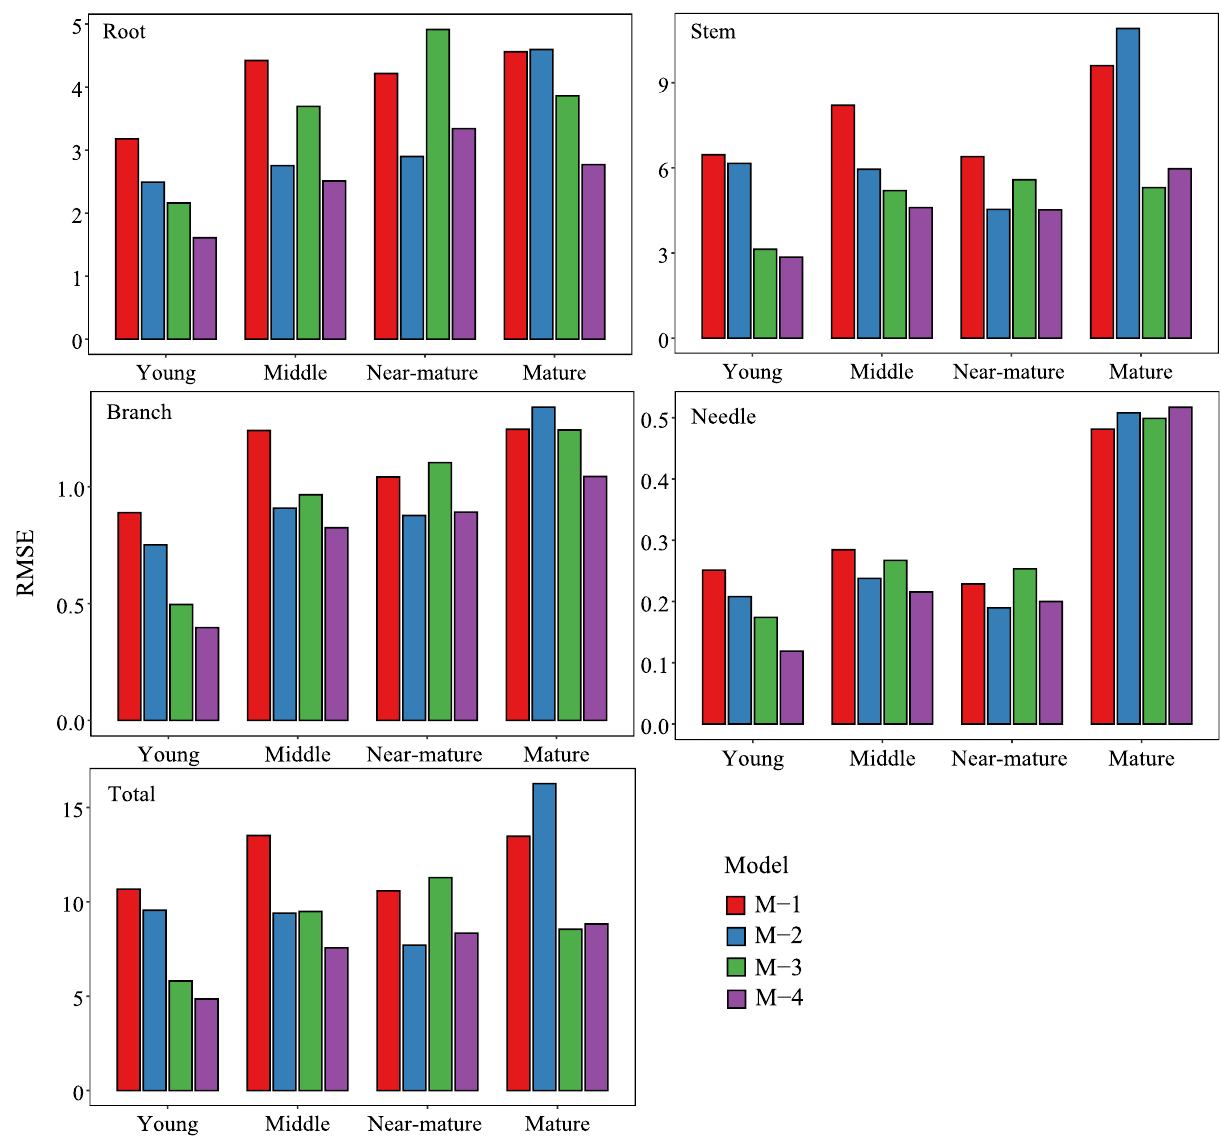
Figure 3. Histogram of the comparison of RMSE between basic model (M-1, M-2) and proposed model (M-3, M-4) in the prediction performance for each component under four stand age groups (Young, Middle, Near-mature, Mature) for larch ( Larix spp.).